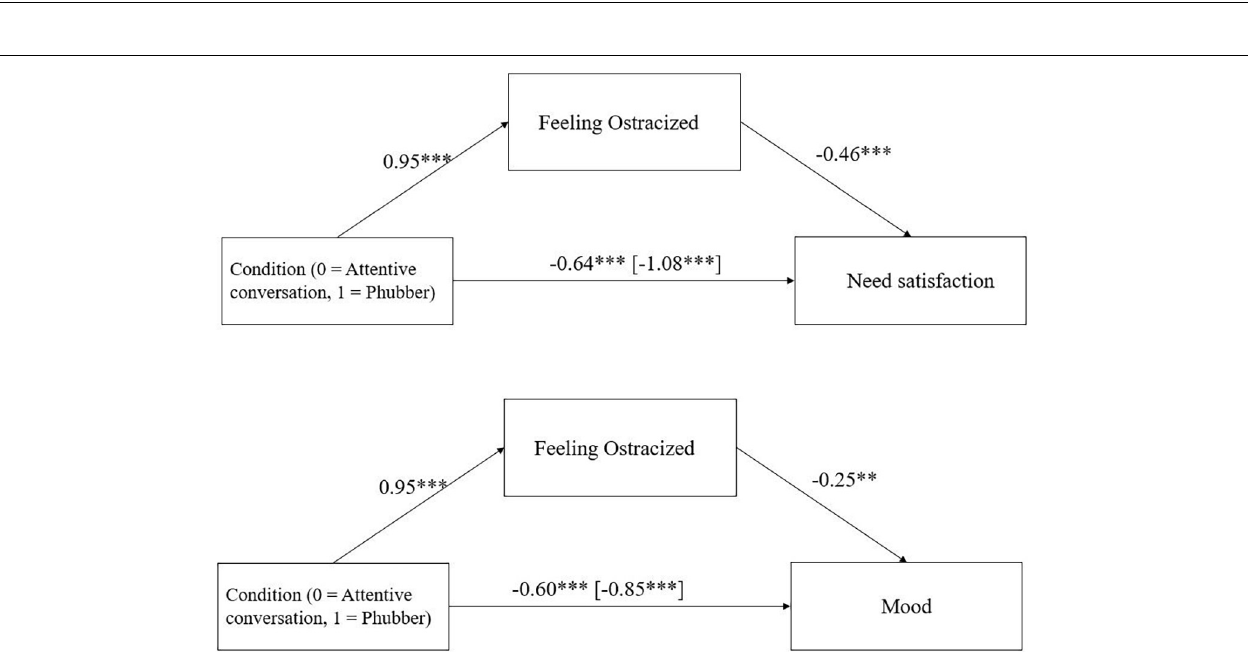
FIGURE 2 | Mediation effect of condition (attentive conversation vs. phubber) via feelings of ostracism on need satisfaction and mood in Study 1 including the direct effect of condition on need satisfaction and mood (with total effect in parentheses). ∗ p < 0.05, ∗∗ p < 0.01, ∗∗∗ p < 0.001.